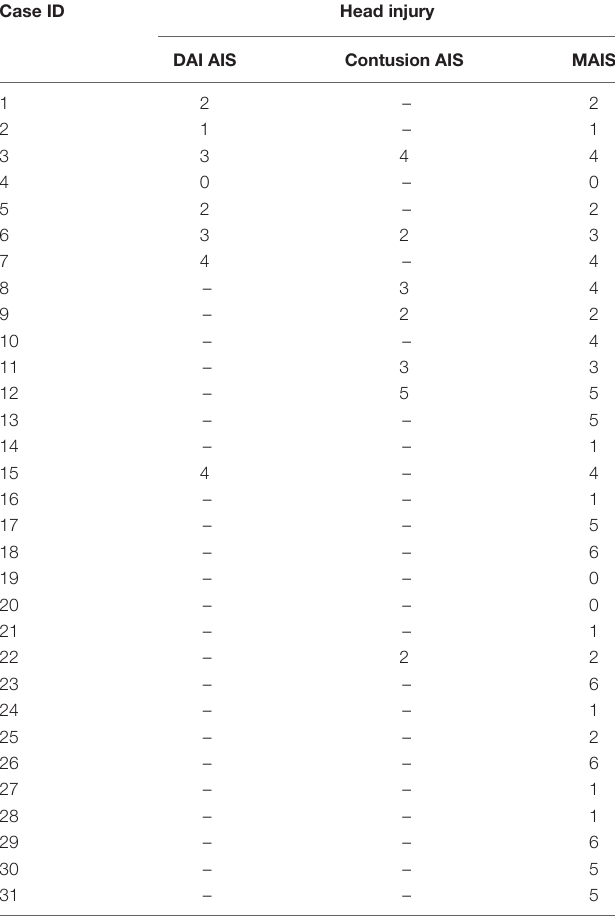
TABLE 2 | VRU head injury rating information for the road traffic accidents subject to this study. Case